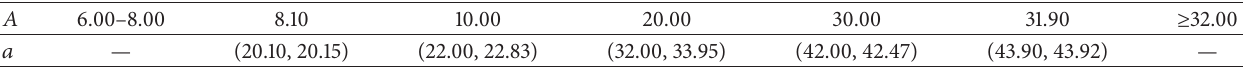
Table 2: The interval of market size incurs 𝑝 ∗∗ < 𝑝 ∗ under 𝐴 > 𝑤𝑏 .